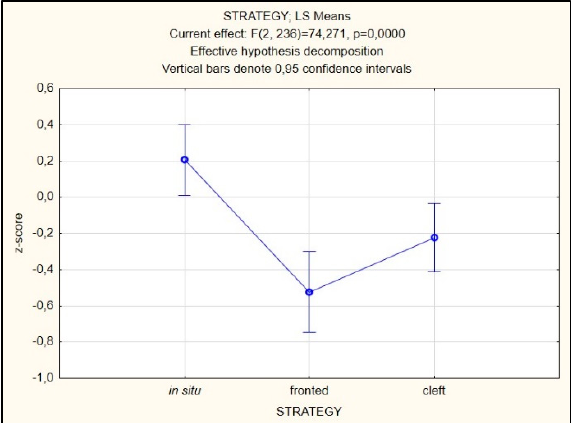
Figure 16. Strategy mean results (Italian) .